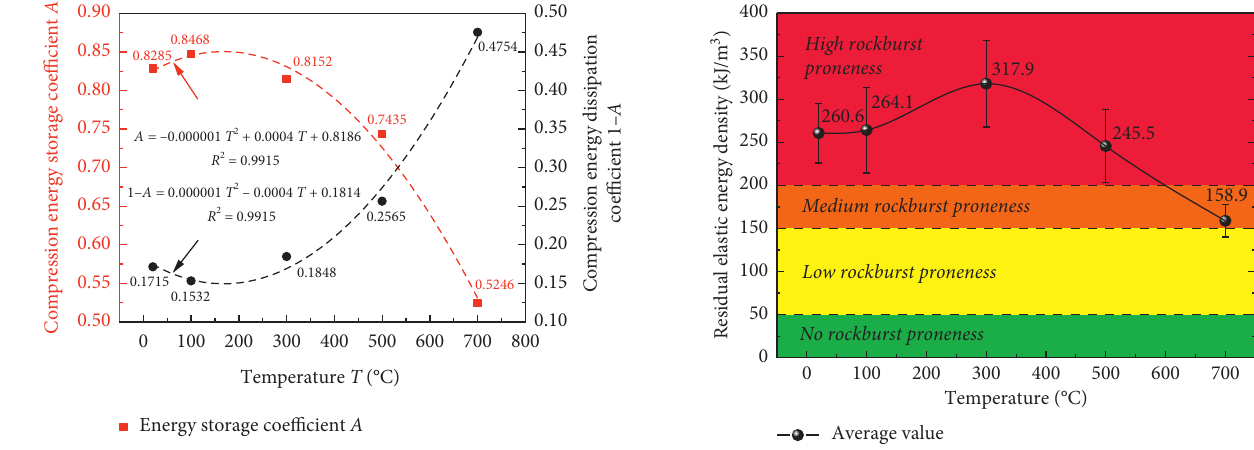
Figure 7: A EF of pre-heated granite specimens under various temperatures [46].